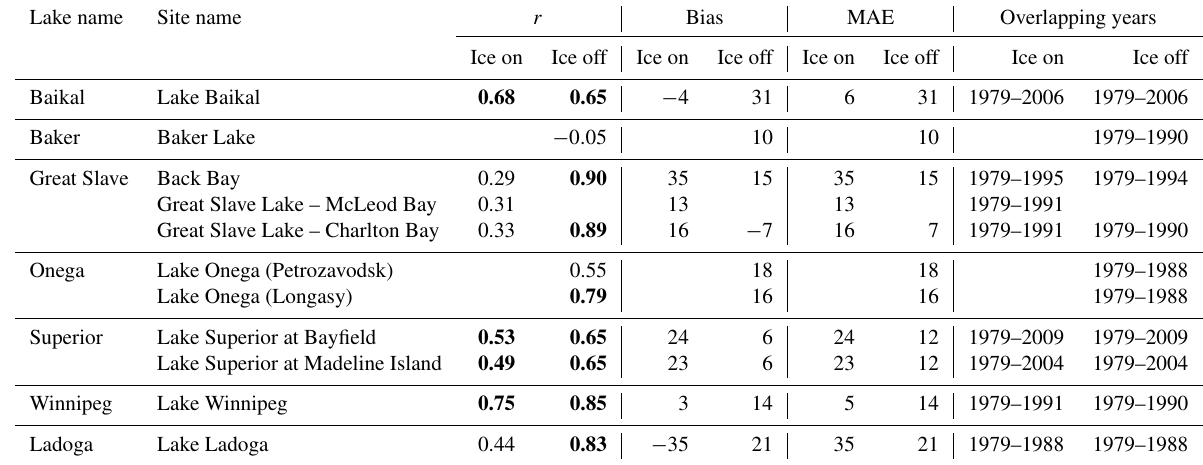
MAE: mean absolute error. Table 4. Comparison of ice-on and ice-off dates from GLRIPD records and SMMR and SSM/I–SSMIS data. Bold numbers correspond to p < 0 .